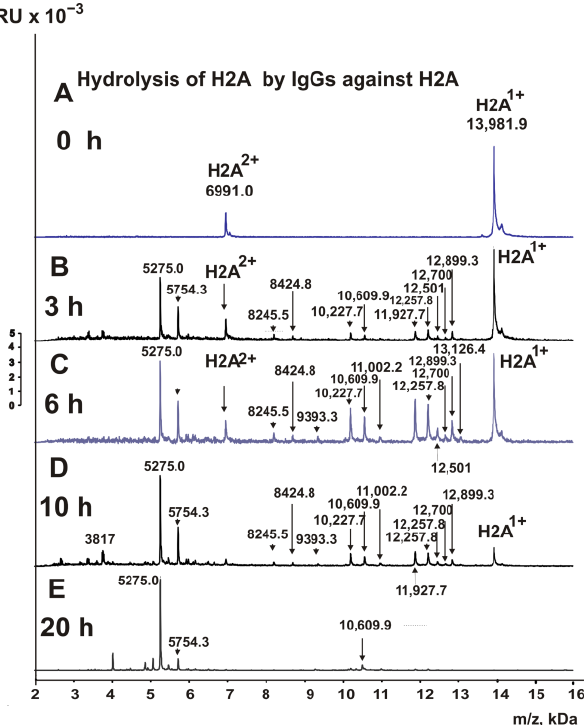
Figure 3. MALDI spectra show H2A histone (0.8 mg/mL) over time during hydrolysis (0 – 20 h) in the presence of IgGs (0.045 mg/mL) against H2A ( A – E ).